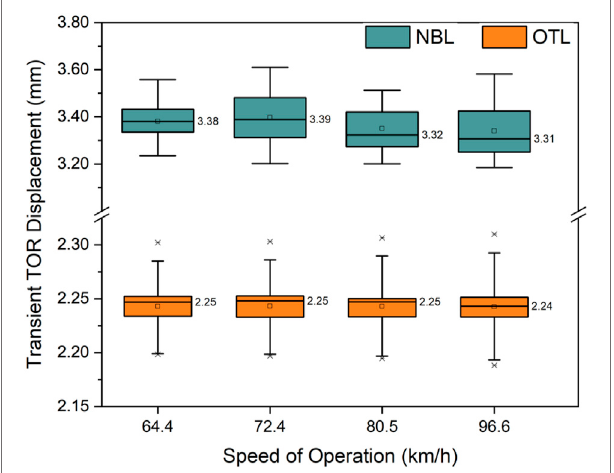
FIGURE 7 | Box plots showing the effect of train speed on transient rail displacement for a freight train set comprising gondola cars.